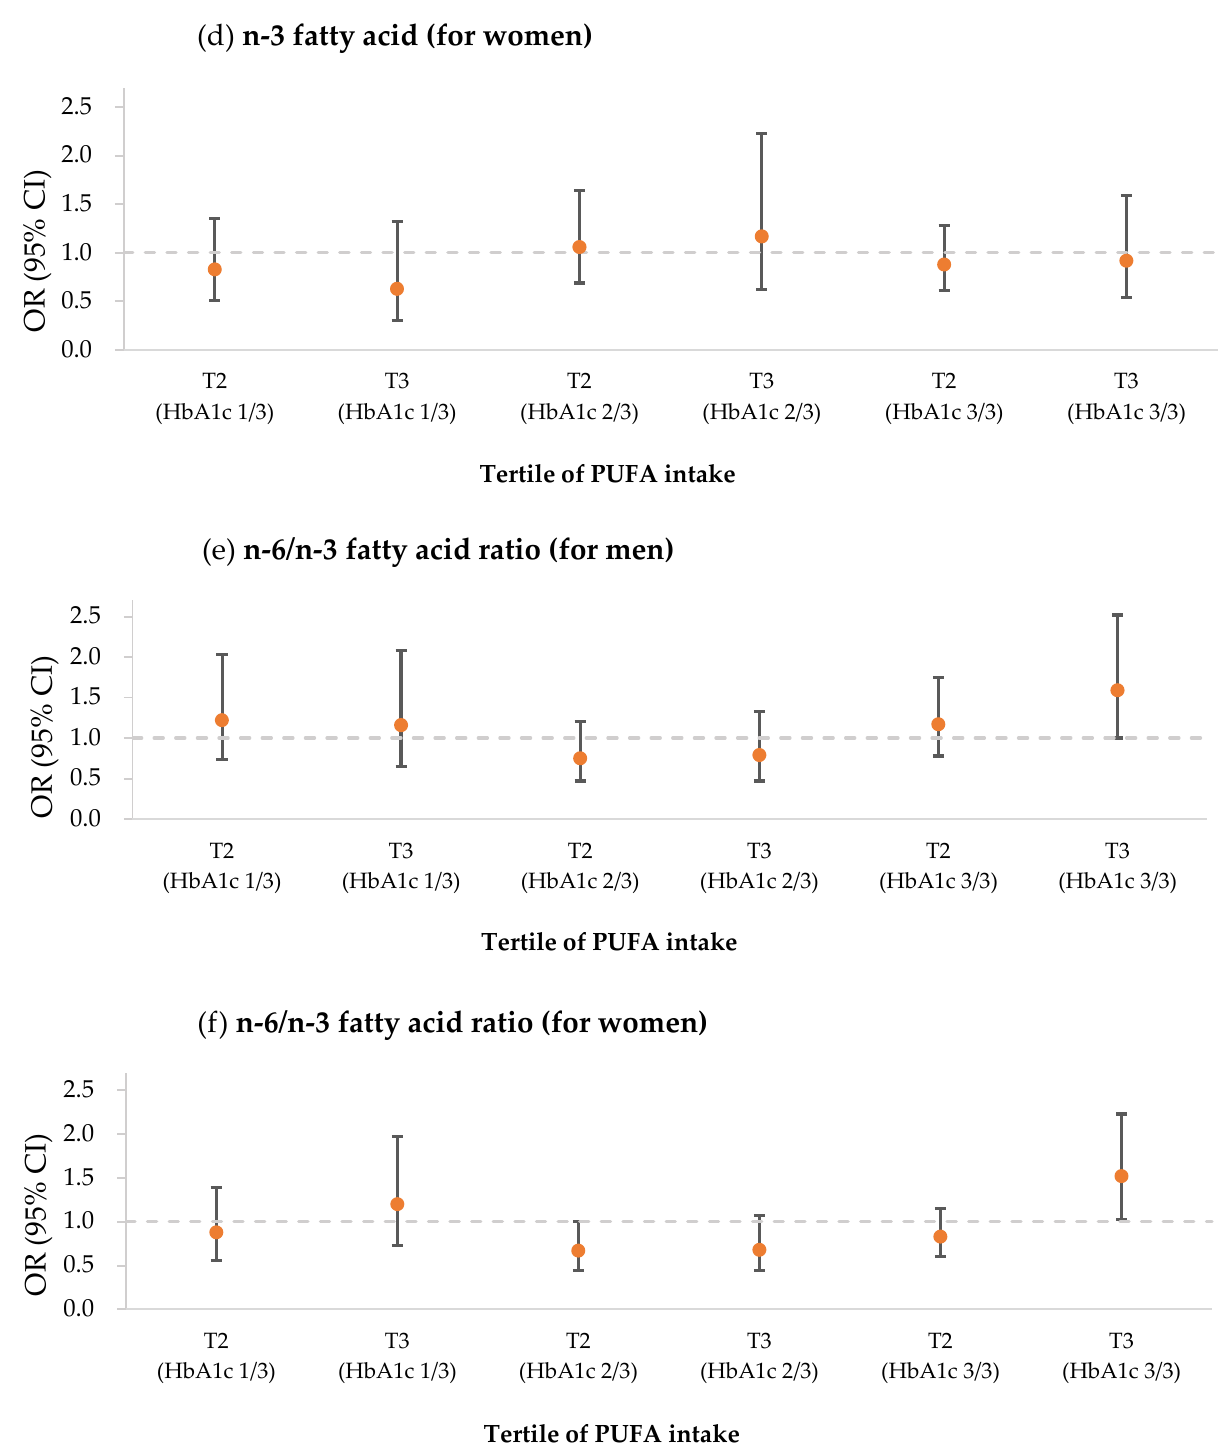
Figure 3. Associations between an tertile increase in PUFA intake and prevalence of metabolic syndrome according to HbA1c level in ( a ) n-6 fatty acid (for men), ( b ) n-6 fatty acid (for men), ( c ) n-3 fatty acid (for men), ( d ) n-3 fatty acid (for women), ( e ) the n-6/n-3 fatty acid ratio (for men), and ( f ) the n-6/n-3 fatty acid ratio (for women) using the odds ratio (OR). ORs were adjusted for age, smoking status, alcohol use frequency, education level, employment status, lowest income quartile, physical activity, and daily intake (energy, carbohydrates, protein, saturated fatty acids, monounsaturated fatty acids, cholesterol, and dietary fiber). Error bars represent the 95% confidence interval for each point estimate. Tertile values for each PUFA intake and HbA1c level are provided in Table 3.